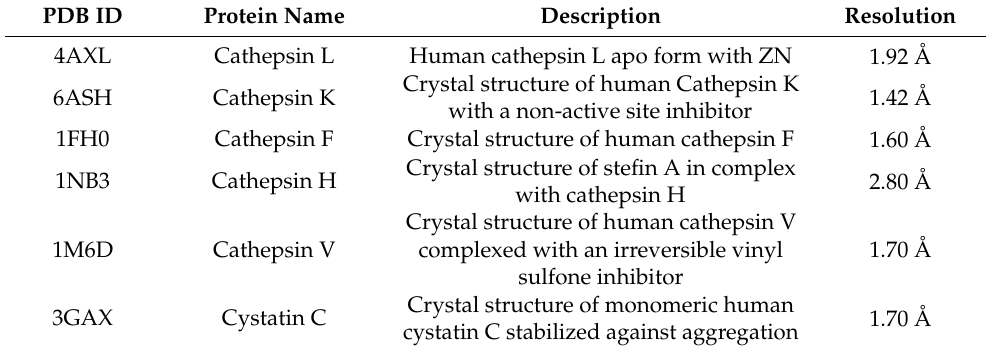
Table 1. Table representing the information related to the PDB files